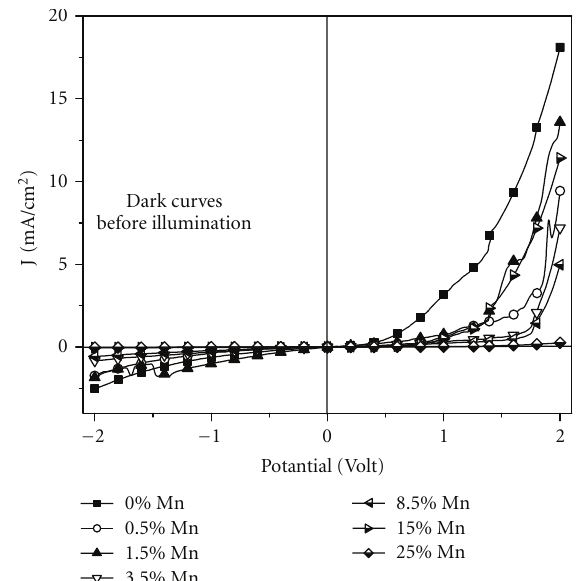
Figure 4: J-V characteristic curves for TiO 2 - and Mn-doped TiO 2 solar cells under dark circumstances (before any illumination process).